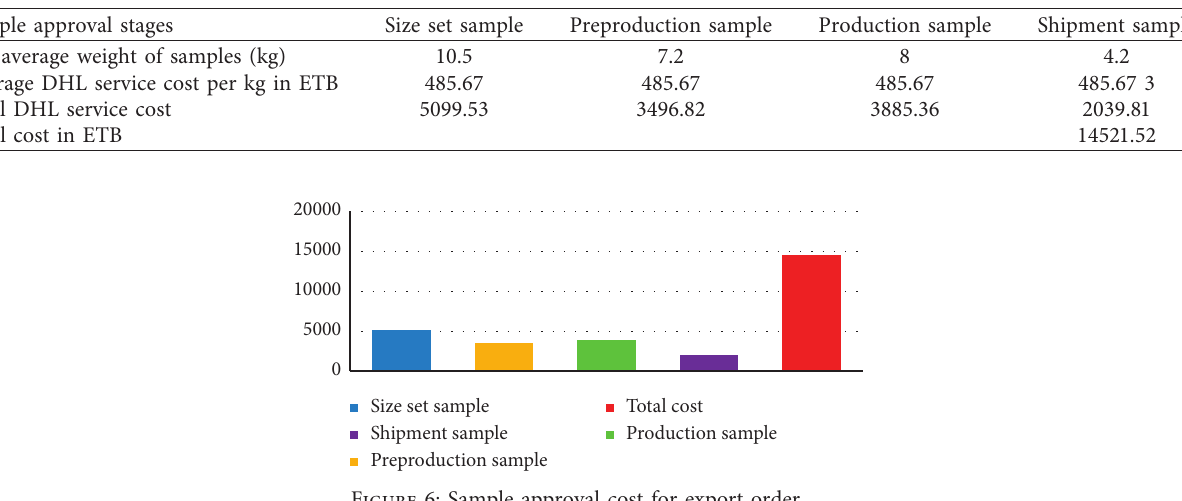
Figure 5: Lead time management status of Ethiopian apparel industries working for export. Table 6: DHL service cost for the sample approval process.